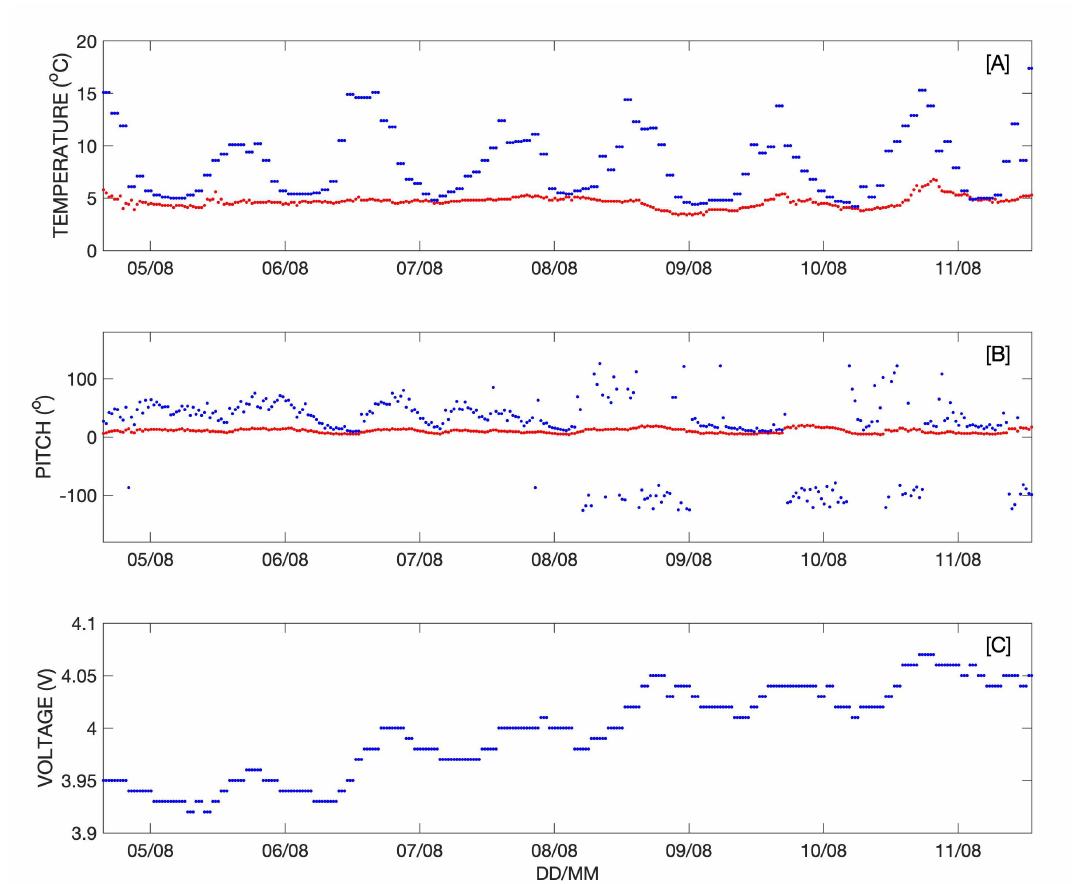
Figure 13. Time series of data recorded by the drifting buoy in the Vagait Strait. ( A ) External (sea surface temperature) and internal temperature are indicated by red and blue markers, respectively. ( B ) Average and maximum pitch are indicated by red and blue markers, respectively. ( C ) Battery